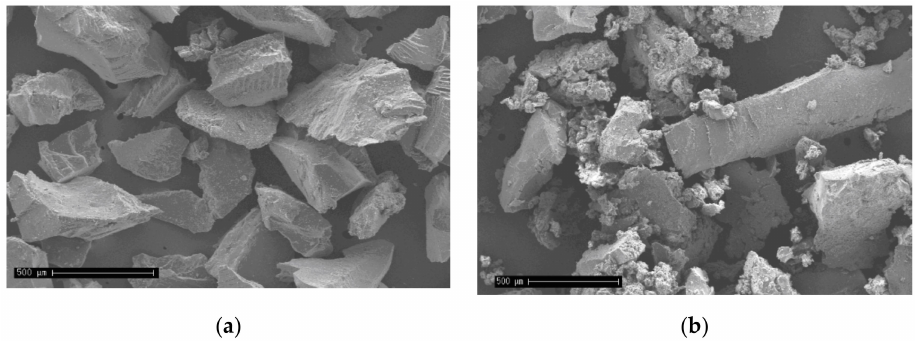
Figure 2. Morphology aspect by SEM (50 times magnification). ( a ) Cryogenic crumb rubber. ( b ) Am- bient crumb